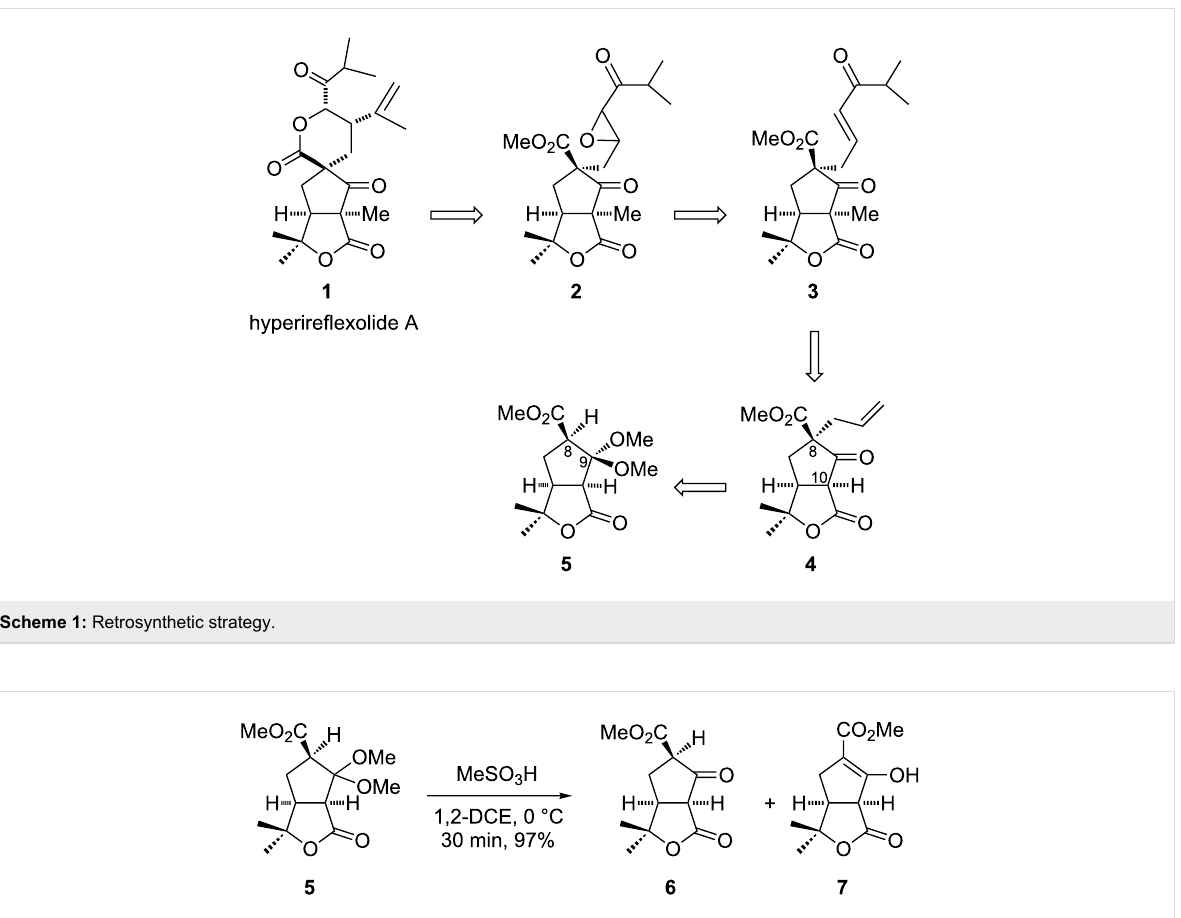
with 2-bromopropene followed by lactonization. Enone 3 could be synthesized from 4 by installation of the methyl group at C-10 followed by cross metathesis reaction. Compound 4 could be obtained from the γ -lactone-fused cyclopentane 5 by depro- tection of C-9 followed by allylation at